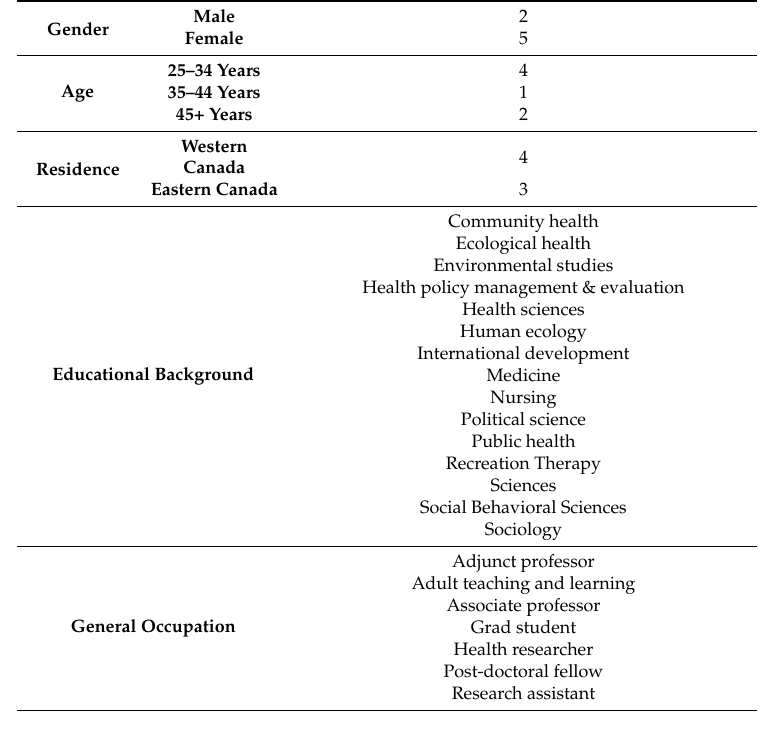
Table 1. Participant Characteristics of Canadian EcoHealth Community Members.